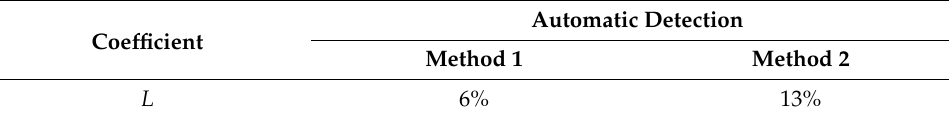
Table 7. Obtained average values of the L